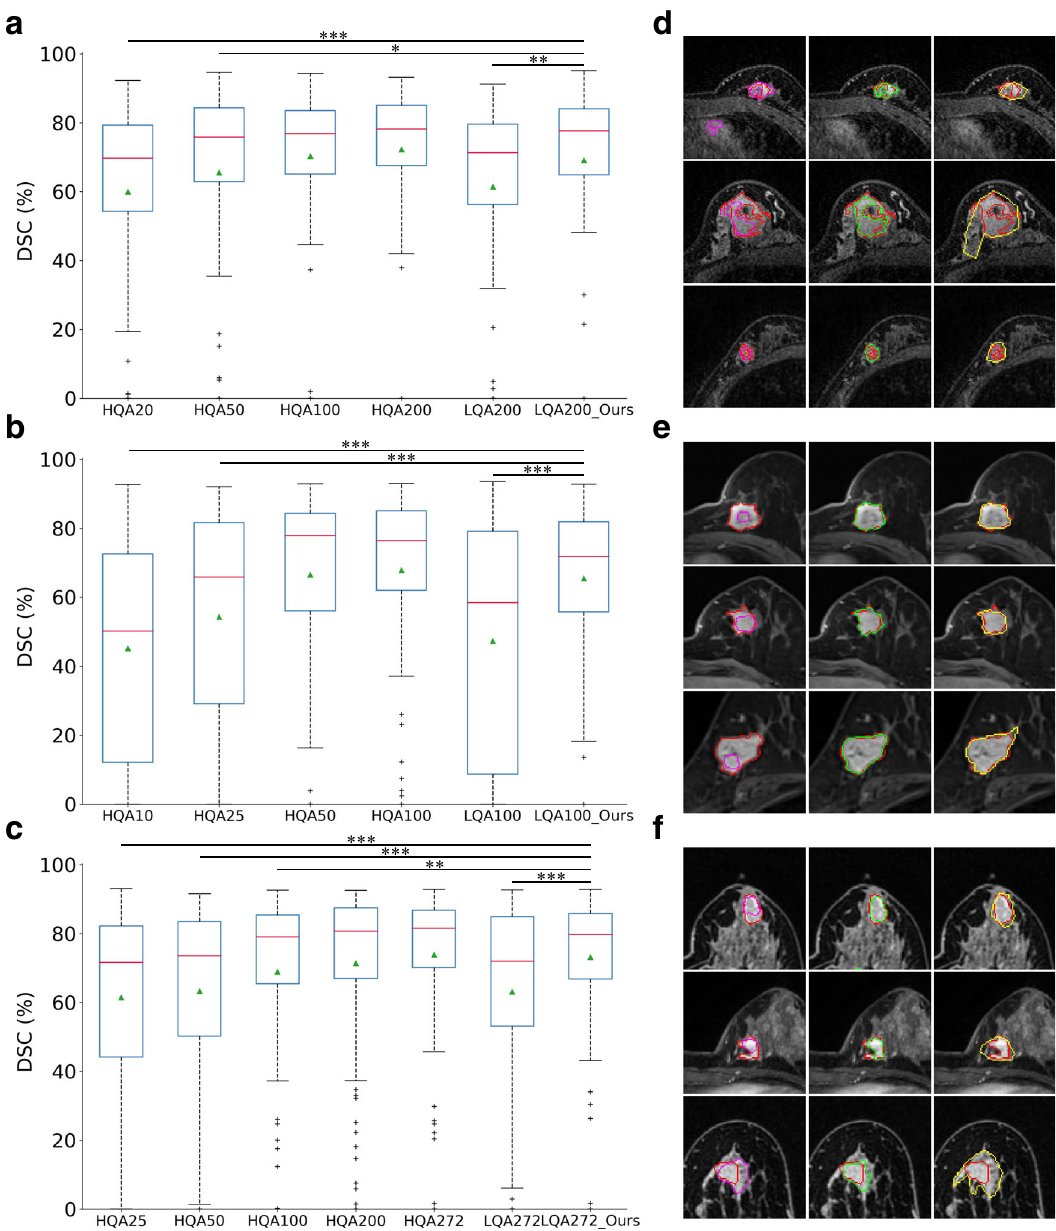
Fig. 4 Results of breast tumor segmentation. a − c Results on GGH, GPPH, and HPPH datasets, respectively. LQA and HQA indicate low- and high-quality annotations. The numbers after HQA refer to the annotations utilized to train the models. For LQA, the numbers indicate that we utilize the respective fewest HQA data with the remaining annotations generated by the pretrained models. For example, LQA200 in ( a ) means 20 high-quality labeled and 180 low-quality labeled data are utilized. Data are represented as box plots. The central red lines indicate median DSC values, green triangles the average DSC values, boxes the interquartile range, whiskers the smallest and largest values, and data points ( þ ) outliers. * indicates a signi fi cant difference between the corresponding experiments, with *** P (cid:2) 0 : 001, ** P (cid:2) 0 : 005, and * P (cid:2) 0 : 05 (two-sided paired t test, n ¼ 100 independent patient cases). a Between HQA20 and LQA200_Ours, P ¼ 0 : 0002; between HQA50 and LQA200_Ours, P ¼ 0 : 0139; between HQA100 and LQA200_Ours, P ¼ 0 : 3119; between HQA200 and LQA200_Ours, P ¼ 0 : 0608; between LQA200 and LQA200_Ours, P ¼ 0 : 0017. b Between HQA10 and LQA100_Ours, P < 0 : 0001; between HQA25 and